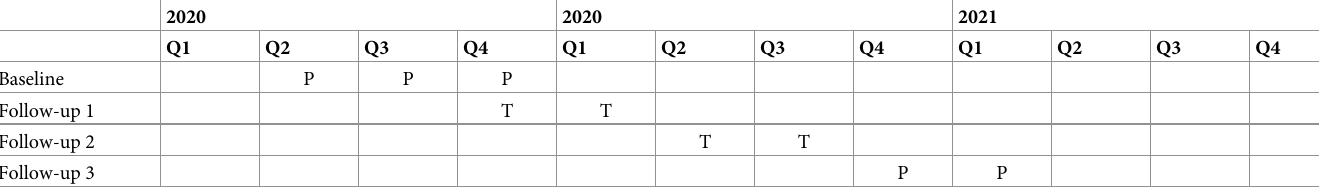
Table 1. Timeline of data collection for the Kosovo Non-Communicable Disease Cohort from baseline to follow-up